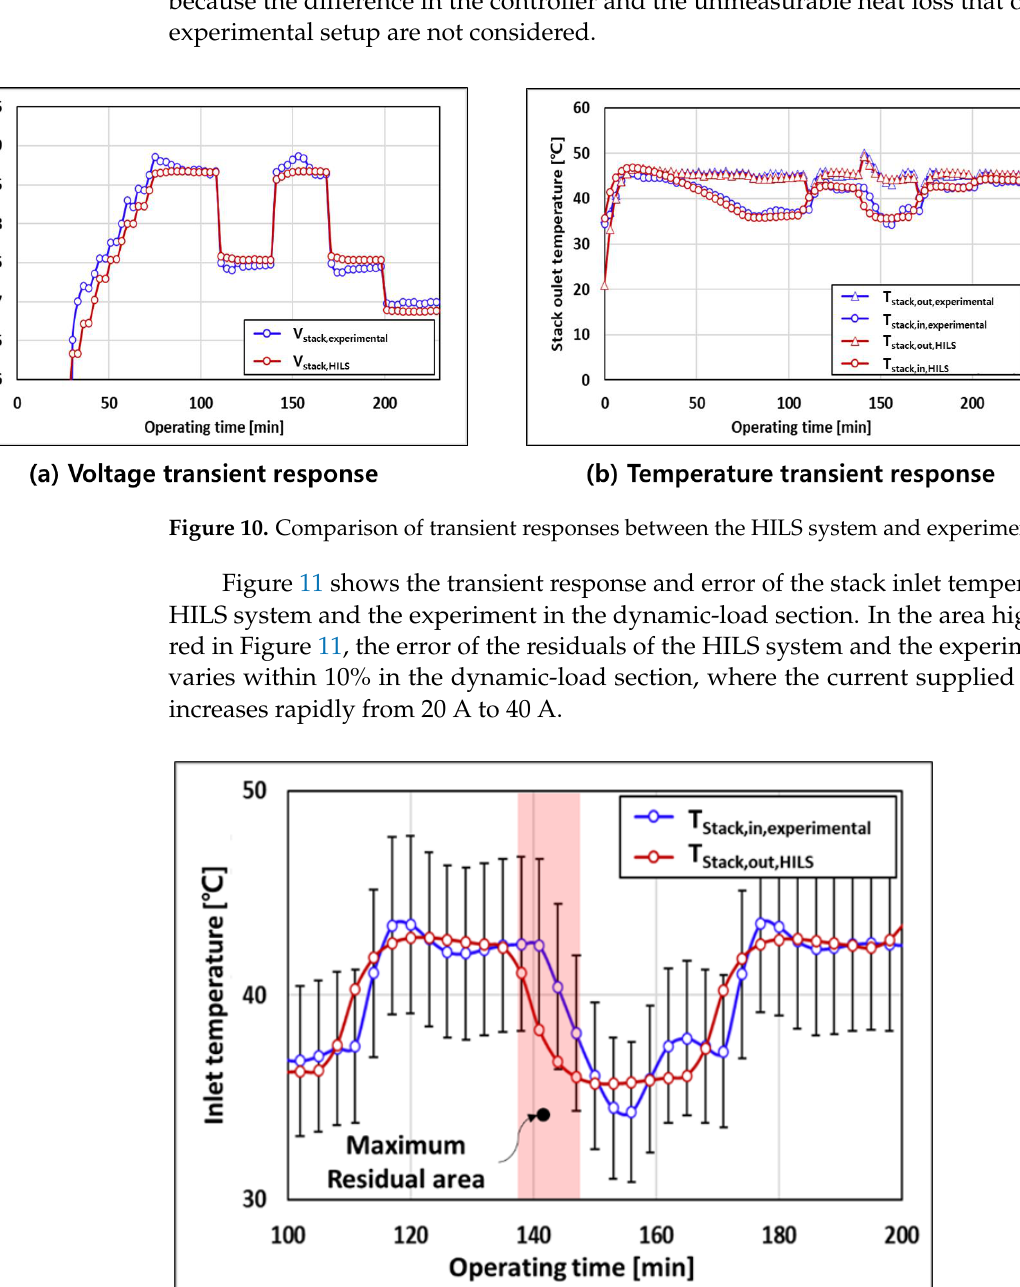
Figure 9. Current profile for the HILS system.